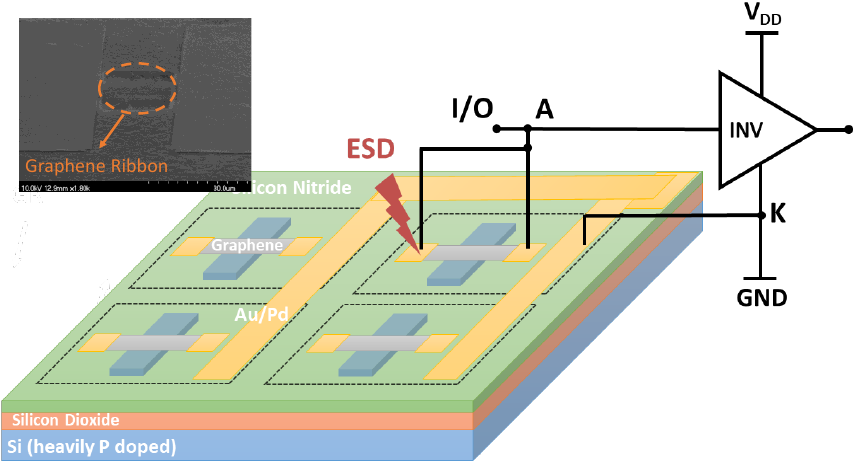
Figure 17. A new gNEMS ESD switch array structure for on-chip ESD protection (Inset: SEM photo for a prototype device fabricated).